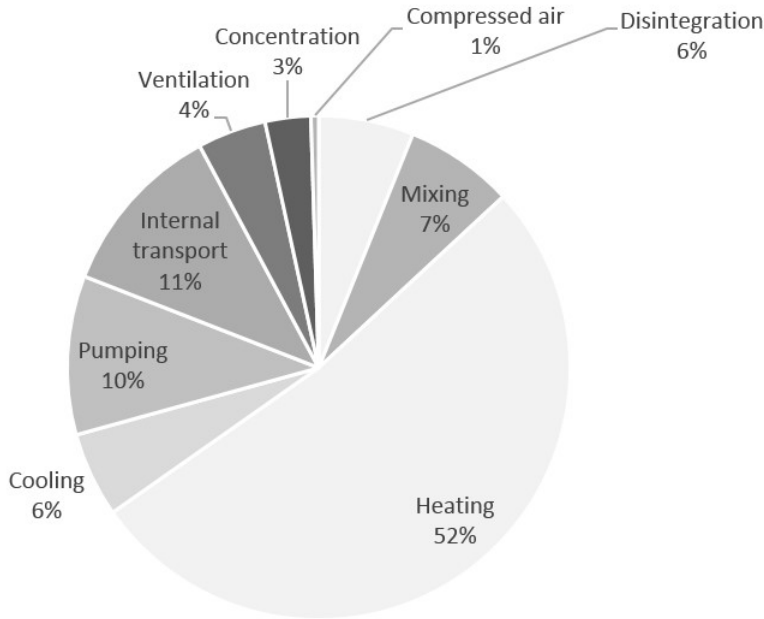
Figure 15. The unit processes for plant B with system Level 2.